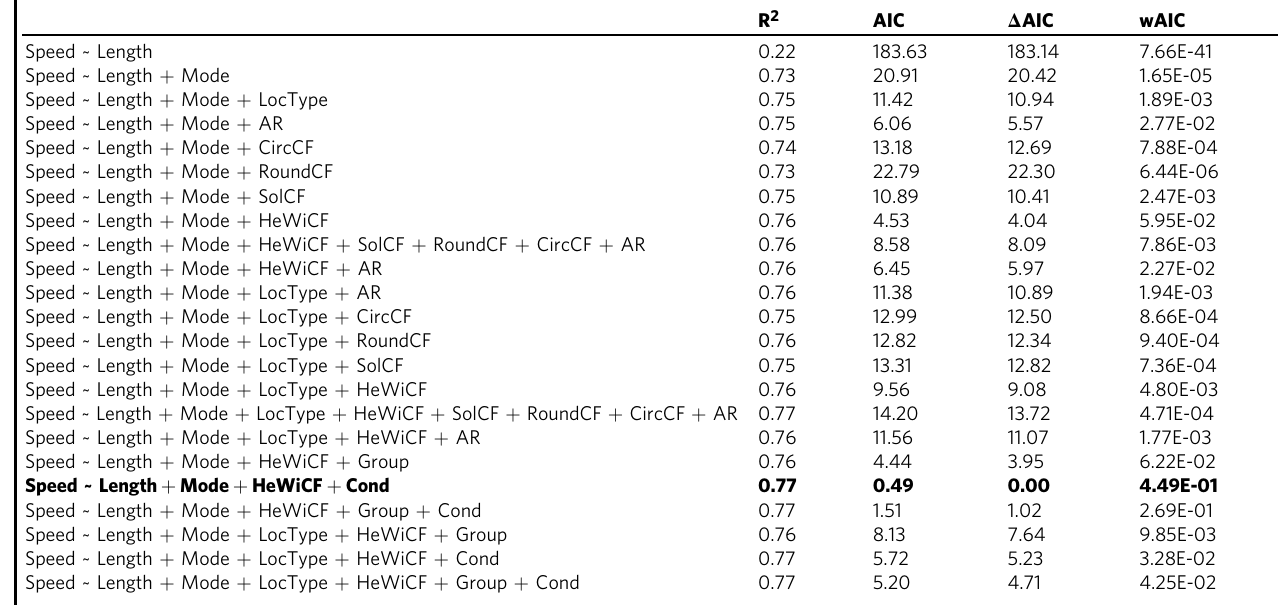
Table 1 Fitting of phylogenetically informed